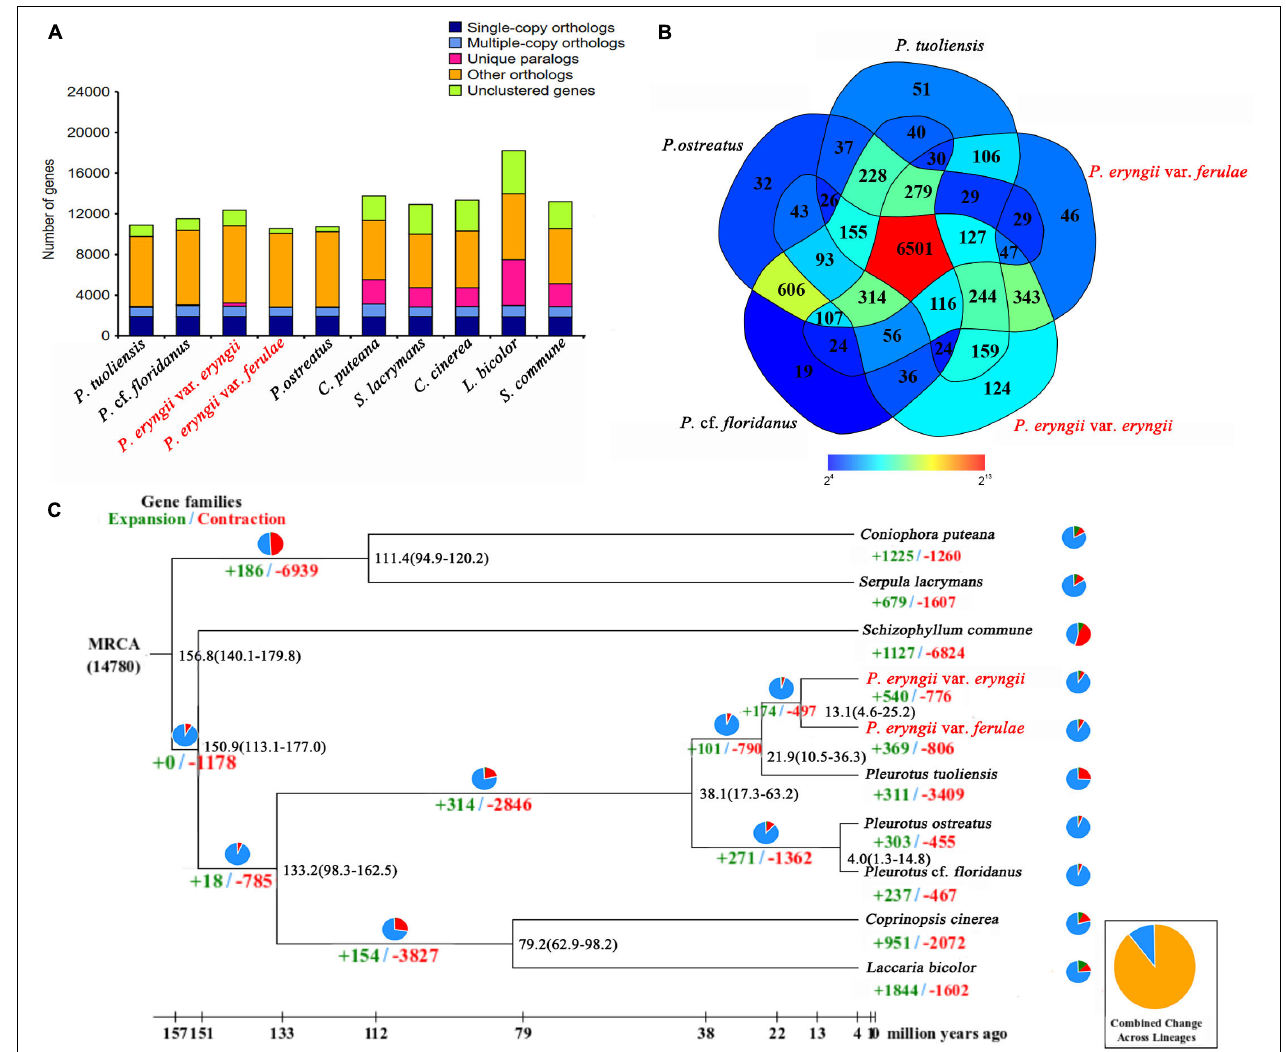
FIGURE 1 | Comparative genomic analysis of P. eryngii. (A) Comparison of orthologous genes among the genomes of 10 fungal species. (B) Unique and shared gene families in the genomes of P. eryngi i var. e ryngii , var. ferulae , P. tuoliensis , P. ostreatus and P. cf. floridanus . The number of unique and shared gene families is shown in each of the diagram components. (C) Numbers on the nodes represent the divergence times. The number of expanded (green) and contracted (red) gene families in each lineage is shown on the corresponding branch. MRCA, most recent common